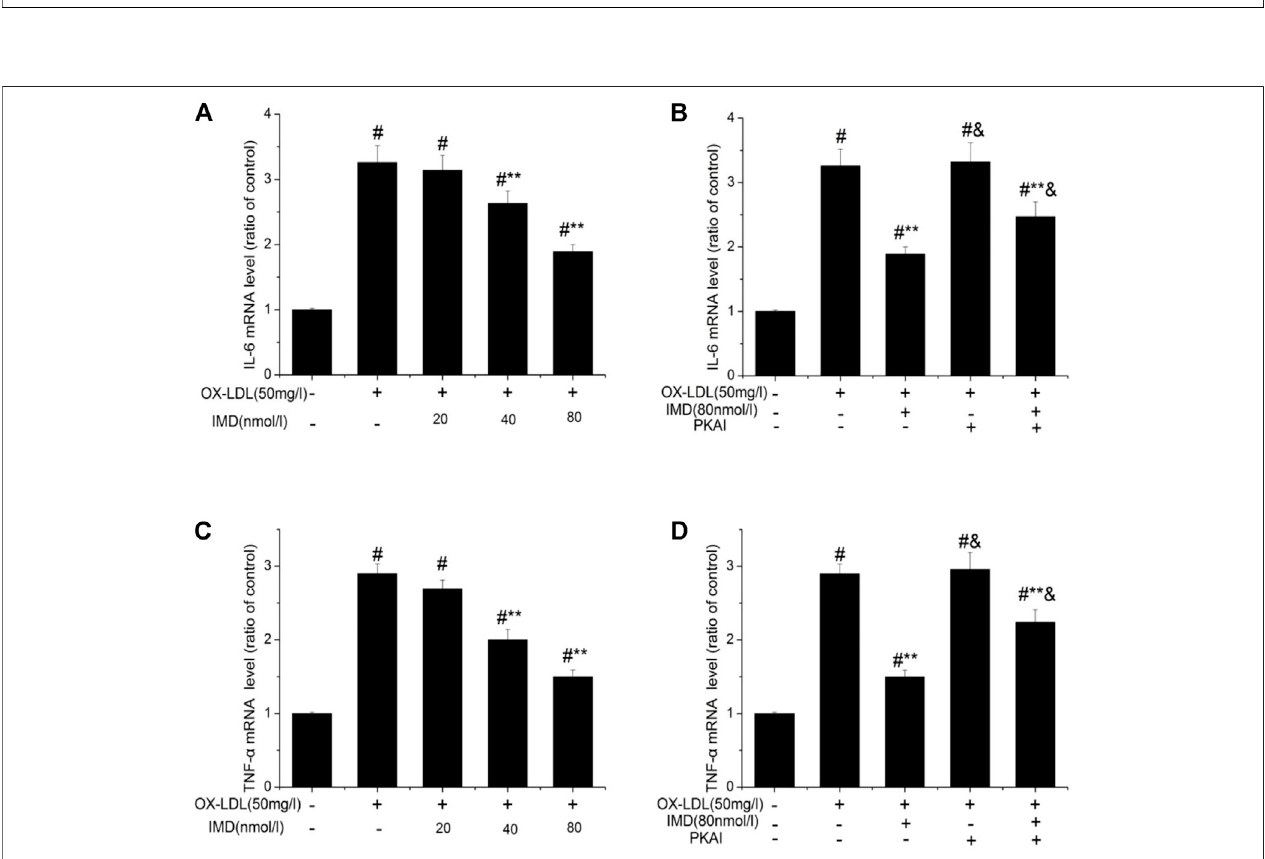
FIGURE 7| IMD inhibits the mRNA expression of IL-6 and TNF- α in ox-LDL – induced macrophages. # Compared with the control group ( p < 0.05); ** compared to the ox-LDL alone group ( p < 0.05); & compared to the ox-LDL +IMD group ( p < 0.05).